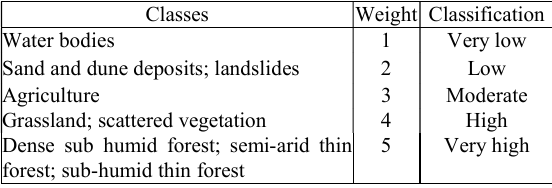
Table 1. Land cover and land use weighting